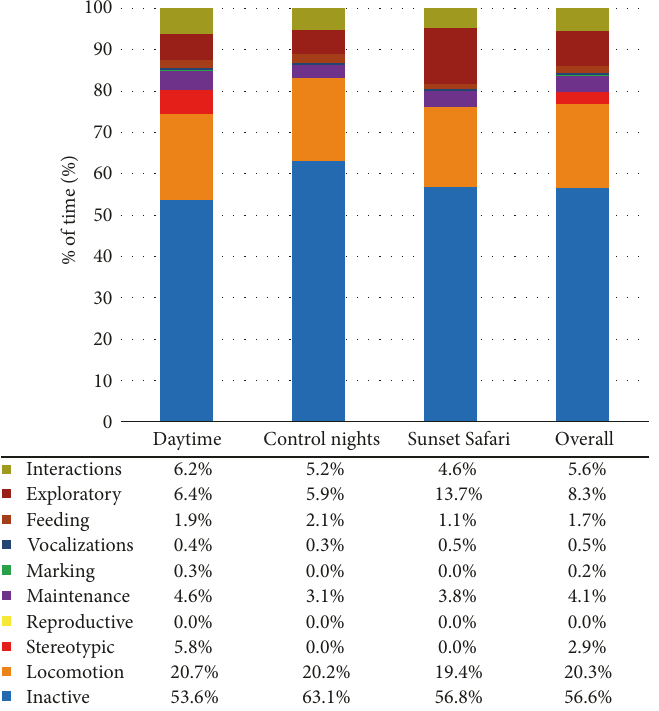
Figure 2: Heidi’s time budget for each observation period and overall at London Zoo. Data values are included to show exact percentages of time for each behavior